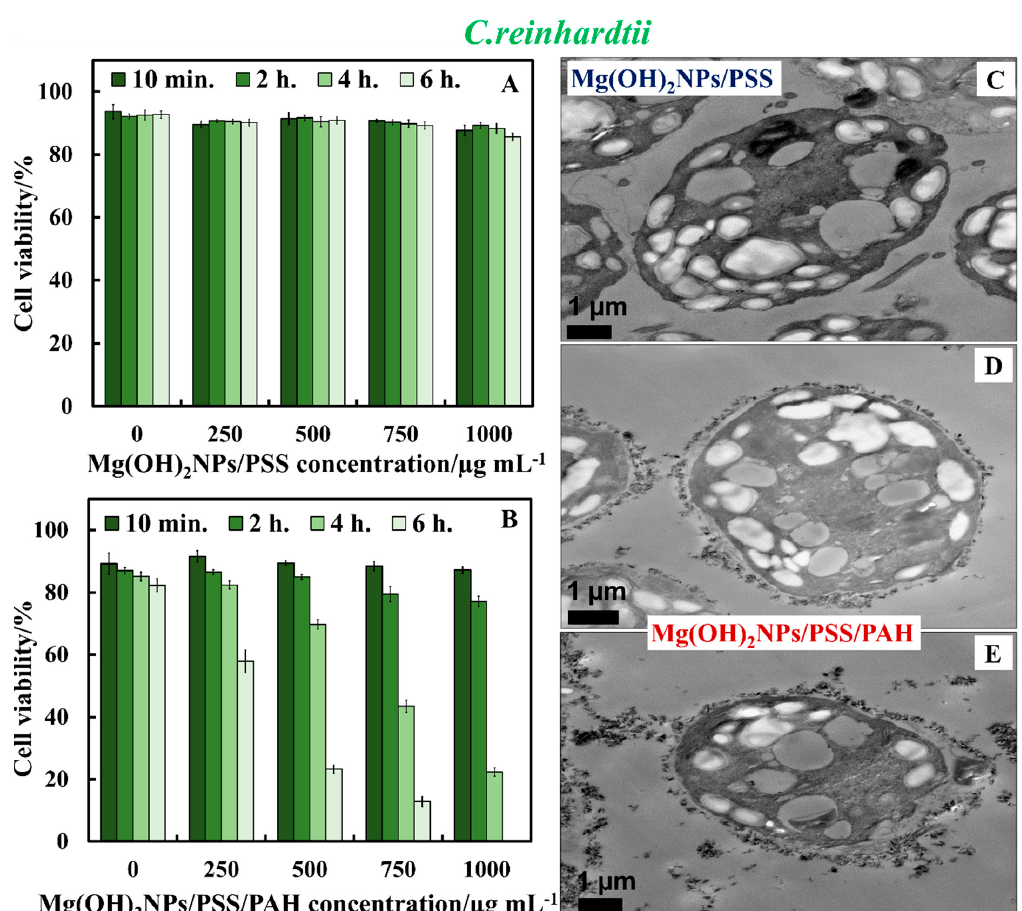
Figure 10. C. reinhardtii cell viability as a function of nanoparticle concentration after incubation for up to 6 h with ( A ) Mg(OH) 2 NPs/PSS and ( B ) Mg(OH) 2 NPs/PSS/PAH. TEM images of C. reinhardtii after being incubated for 6 h with ( C ) 1000 µg mL − 1 Mg(OH) 2 NPs/PSS, ( D ) 750 µg mL − 1 Mg(OH) 2 NPs /PSS/PAH, and ( E ) 1000 µg mL − 1 of Mg(OH) 2 NPs /PSS/PAH.